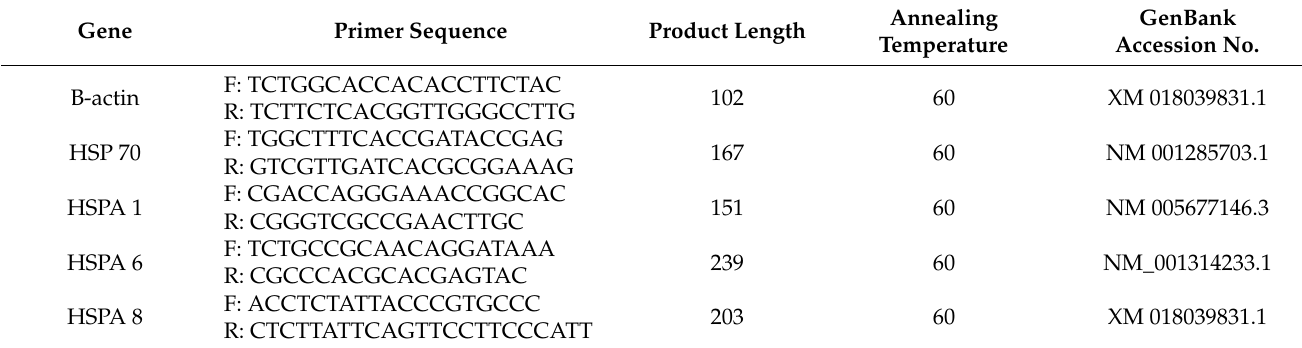
Table 2. The details of primer sequences of HSP 70